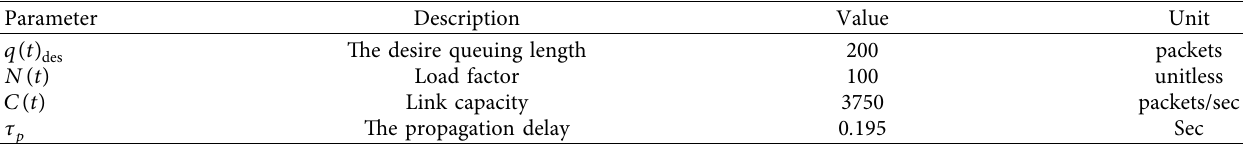
Table 1: TCP network model parameters.